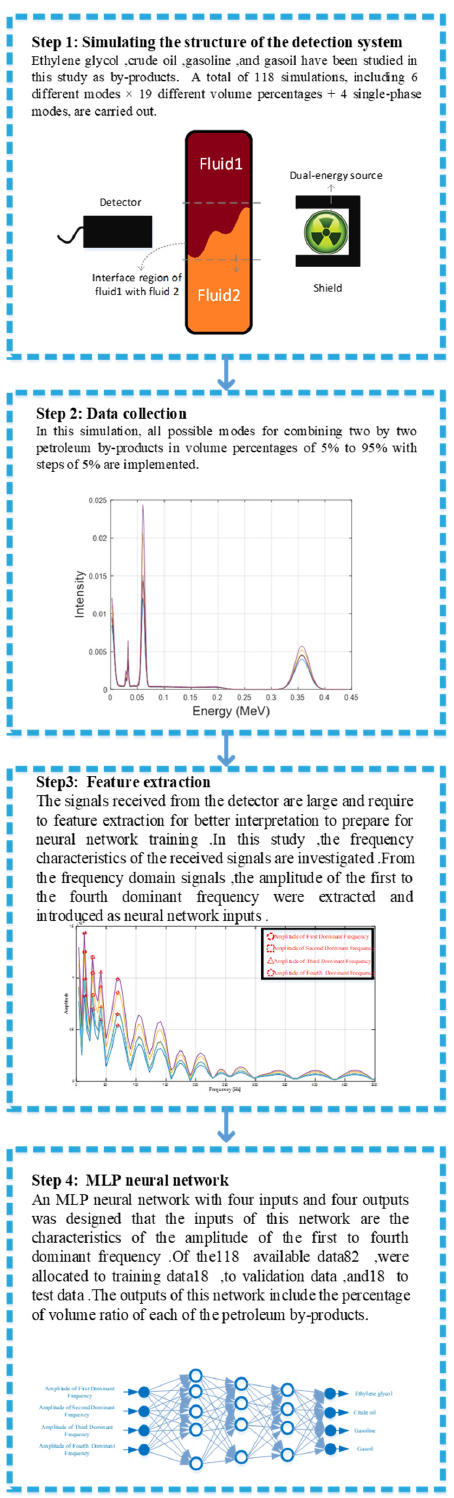
Figure 9. The general process of the research to determine the volumetric ratio of petroleum prod- ucts.